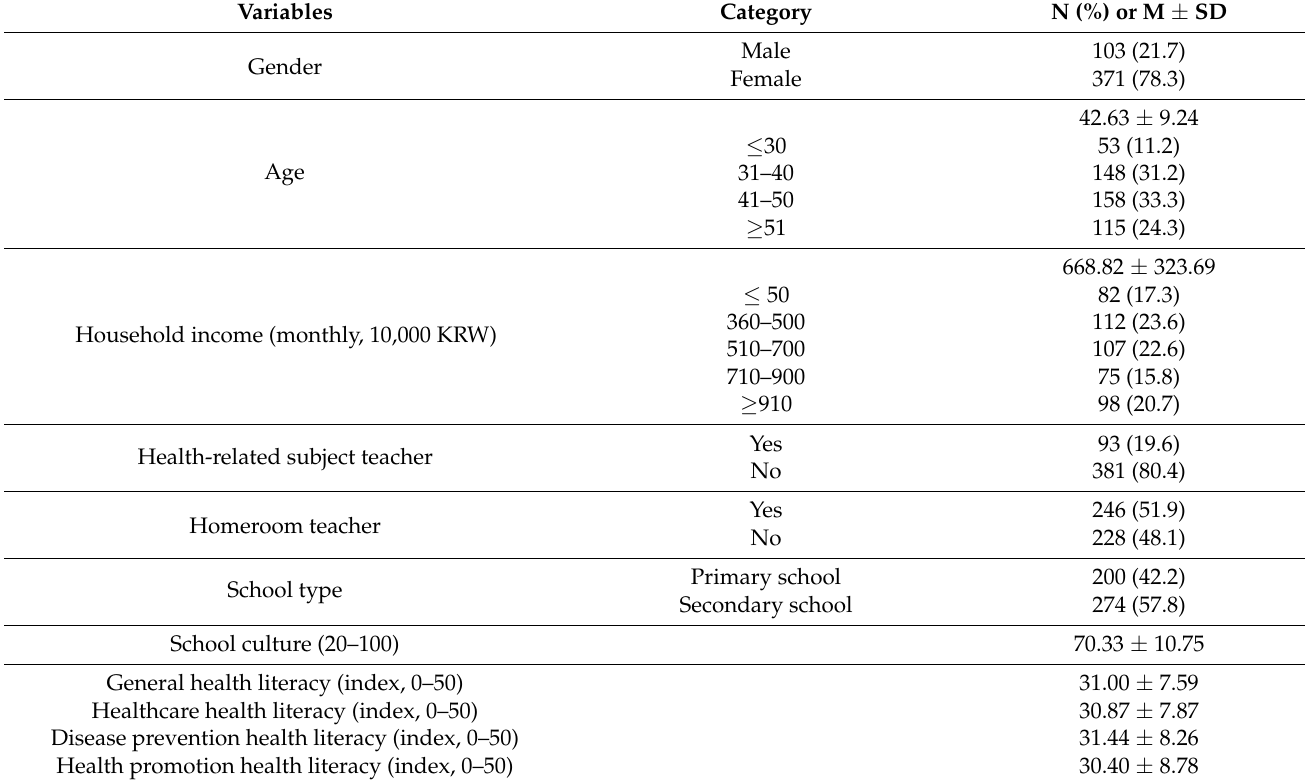
Table 1. Characteristics of the participants ( N =